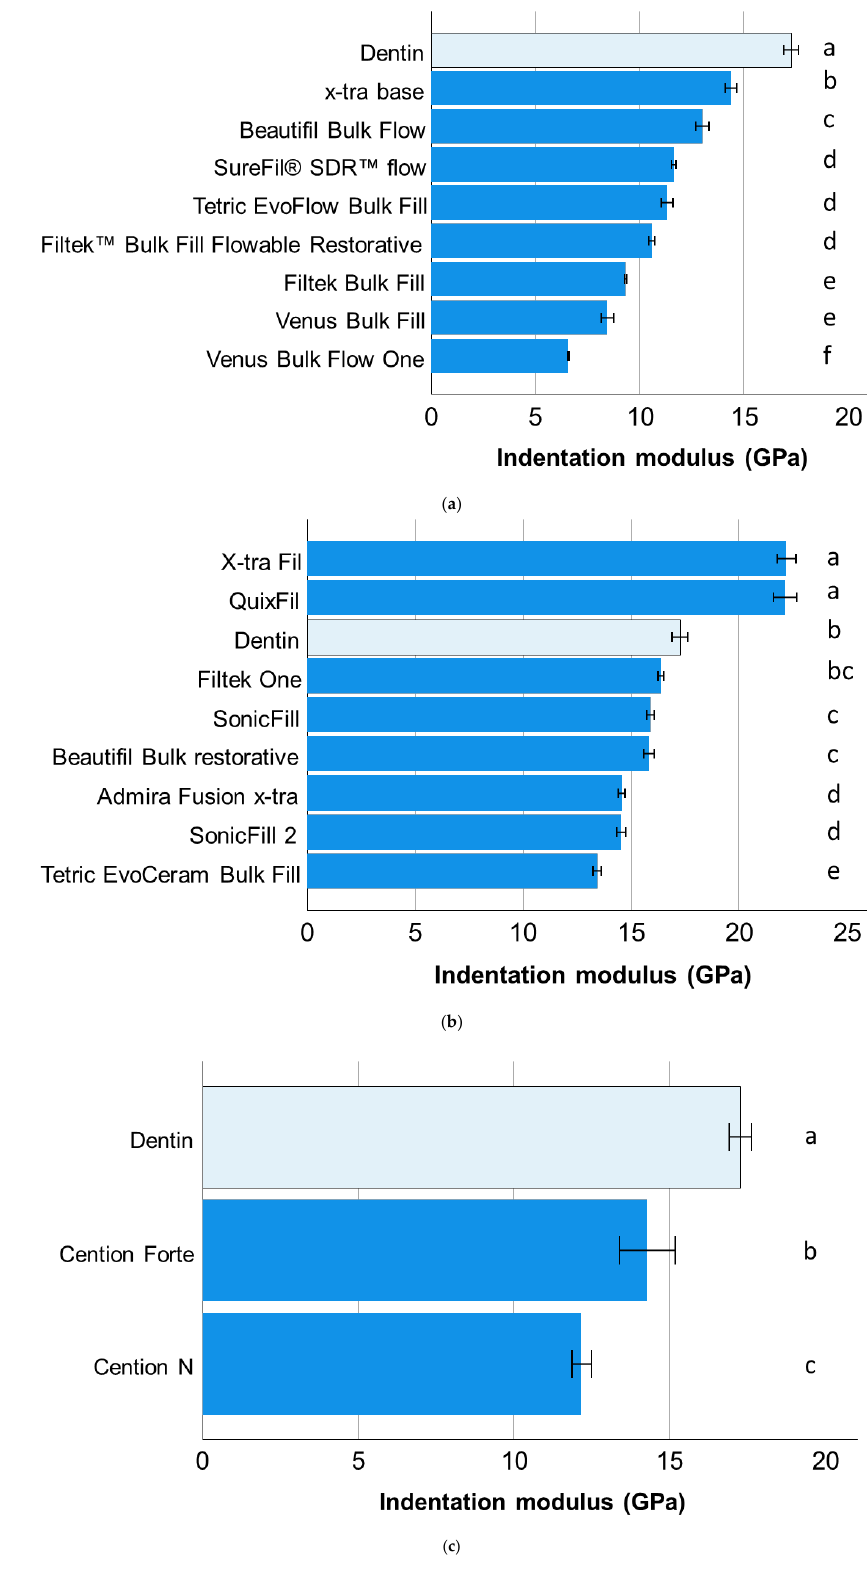
Figure 3. Indentation modulus (means with 95% confidence interval) as a function of RBC and bulk-fill category: ( a ) light-cured, low-viscosity bulk-fill RBCs; ( b ) light-cured, high-viscosity bulk-fill RBCs; and ( c ) dual-cured bulk-fill RBCs. Letters indicate homogeneous groups within each material category; Tukey ’ s post-hoc test ( α = 0 .05).